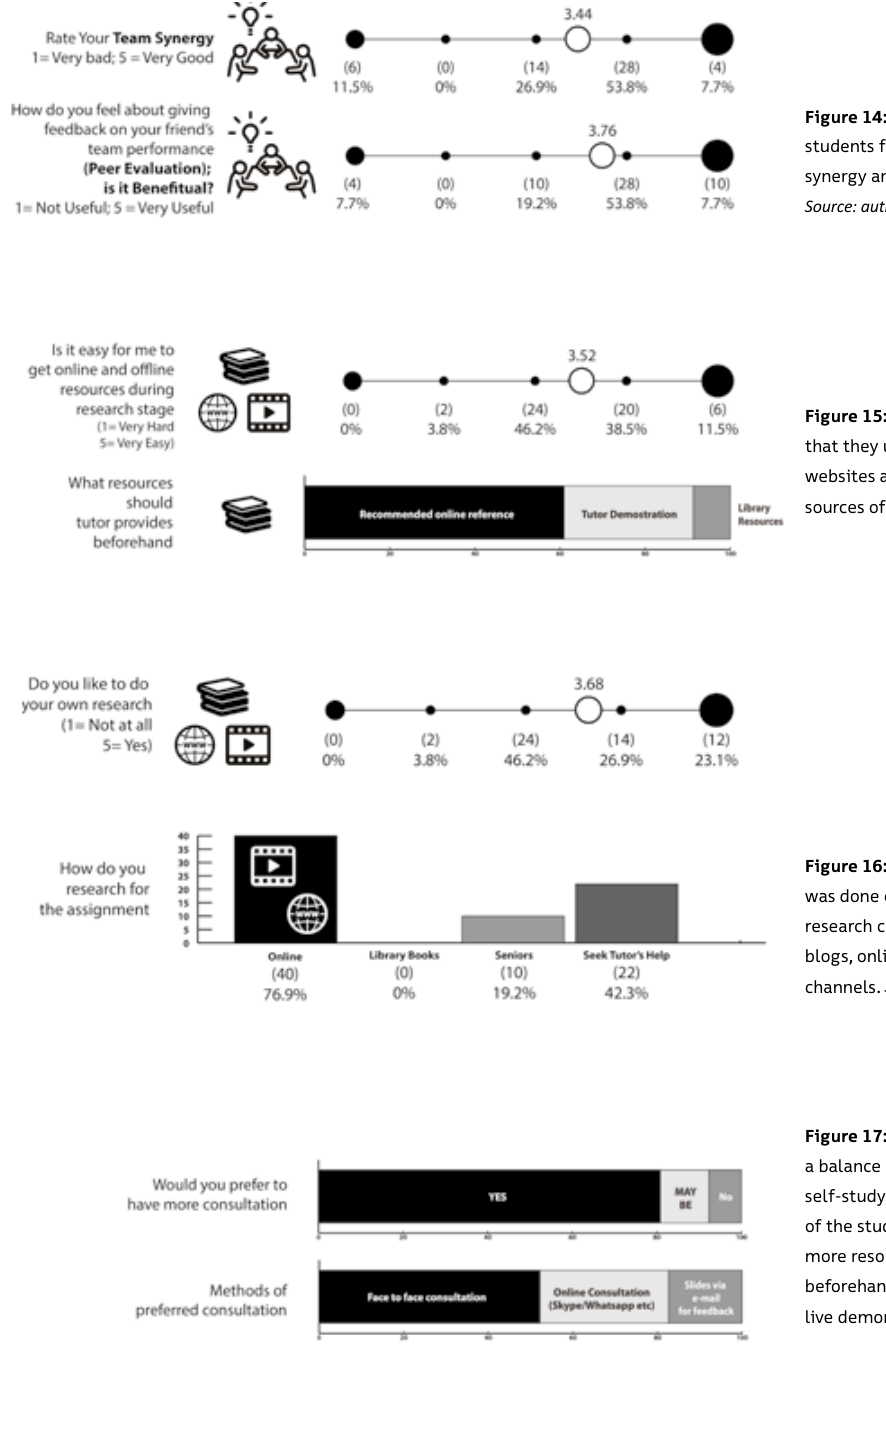
Figure 14: More than 60% of the students felt that they had good team synergy among their peers.